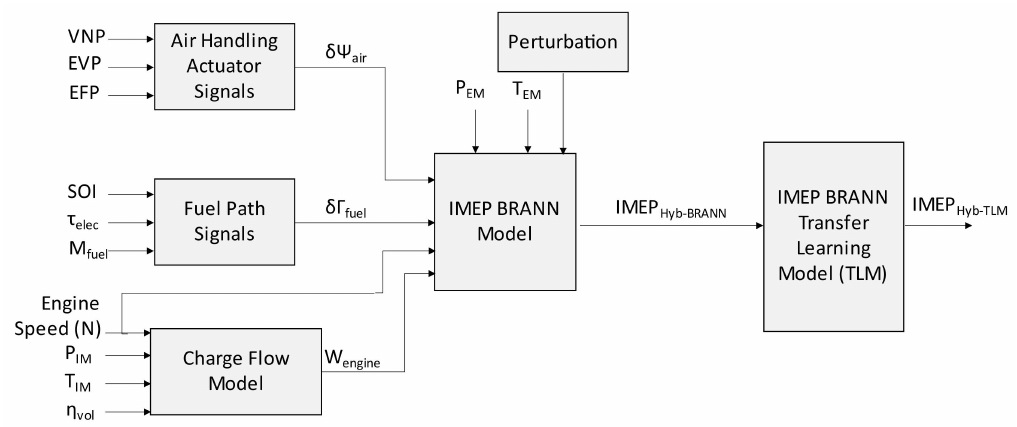
Figure 19. IMEP hybrid model framework.